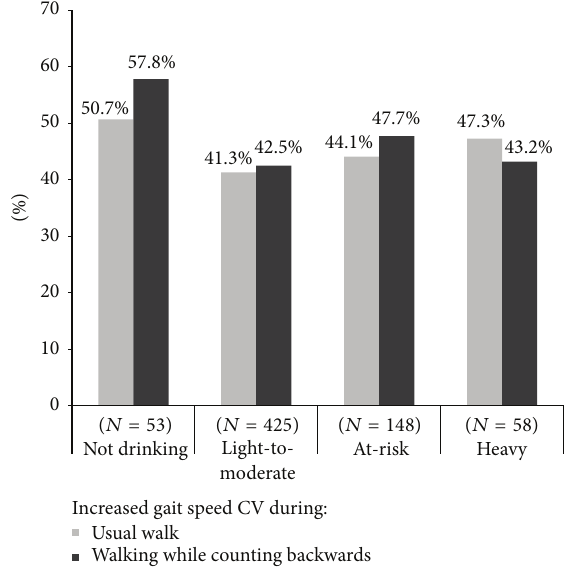
Figure 1: Proportion of participants with increased gait speed variability at 3-year follow-up as compared to baseline, according to alcohol intake and walking